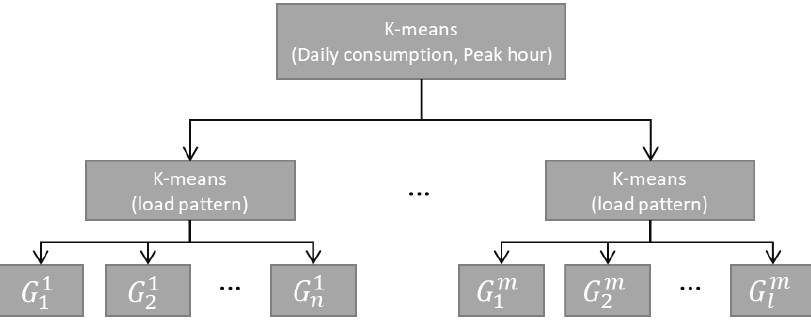
Figure 2. Two-stage clustering methodology for load profile segmentation.